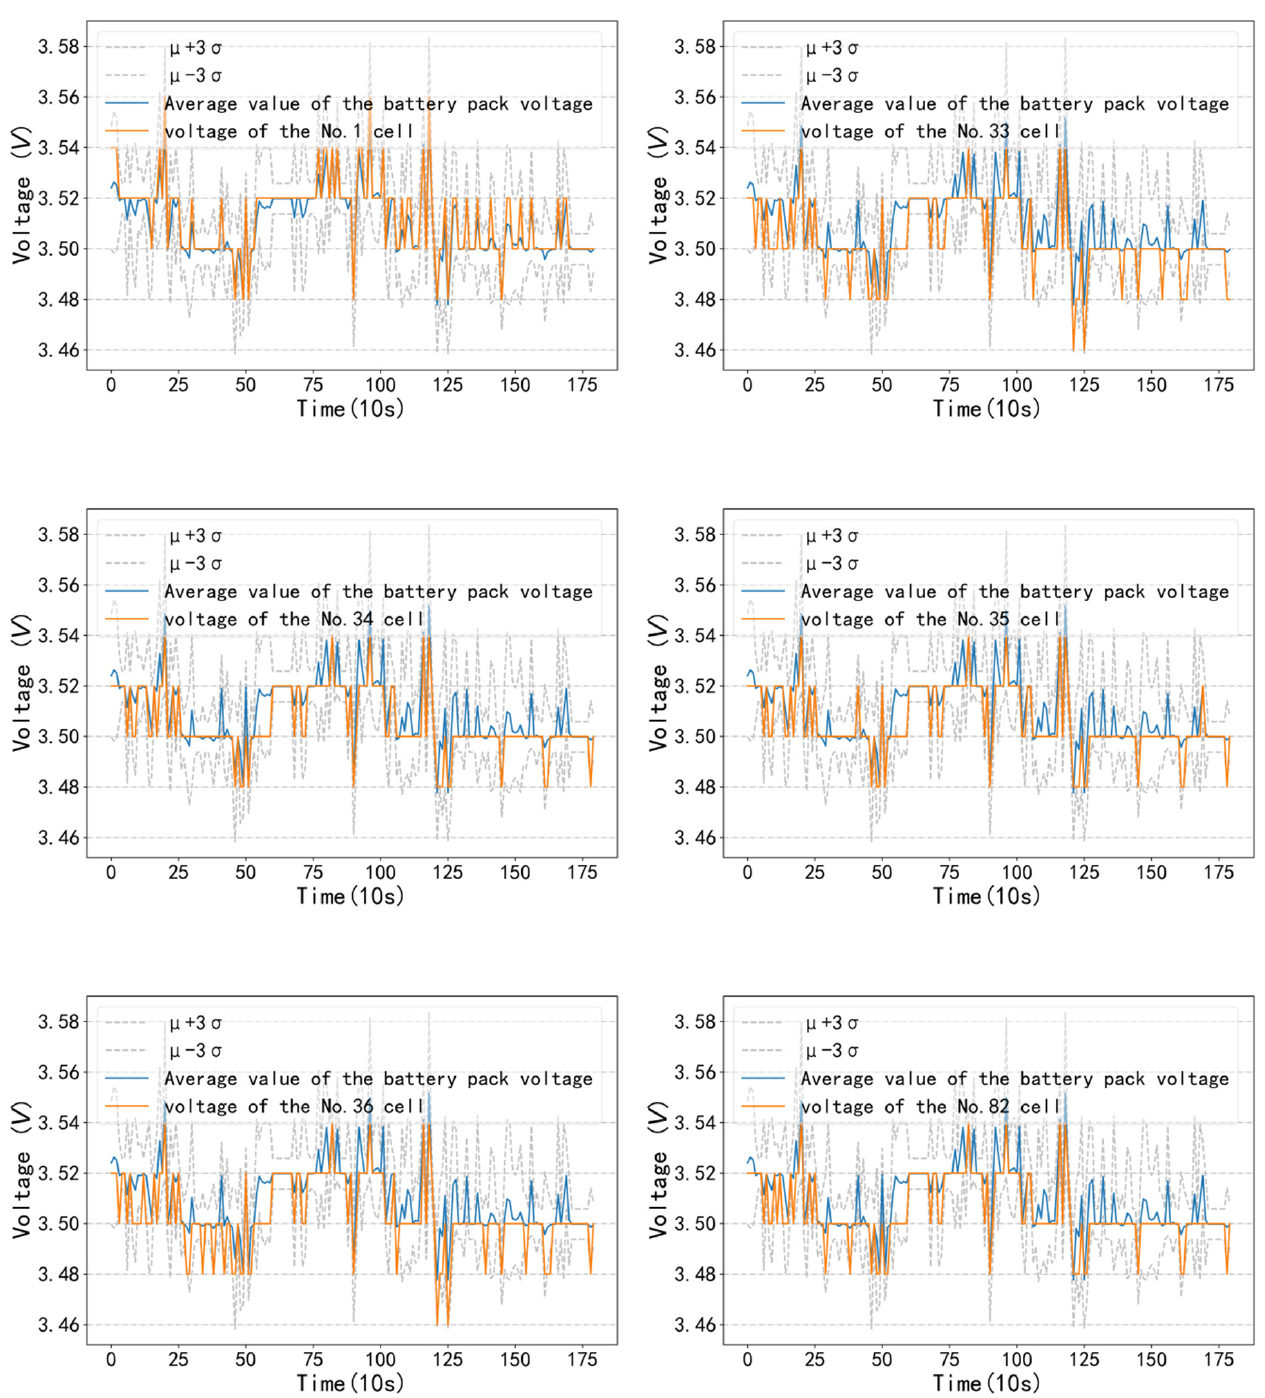
Figure 13. Graphs of the voltage of single batteries over time.